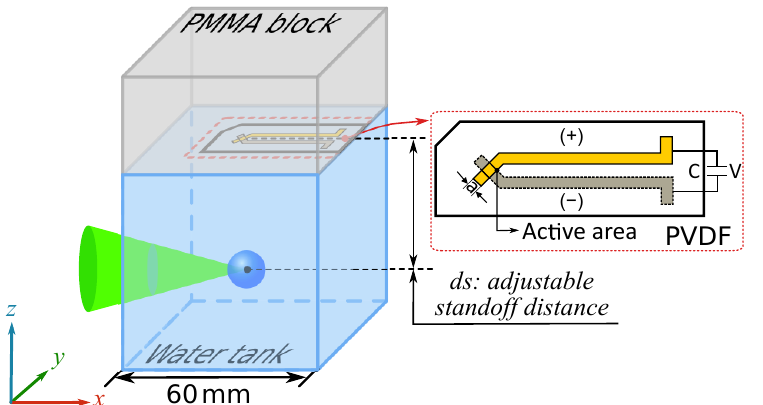
Figure 2. Schematic of the relative position of bubble in the water tank, the installation position of the PVDF sensor and the structure of the PVDF